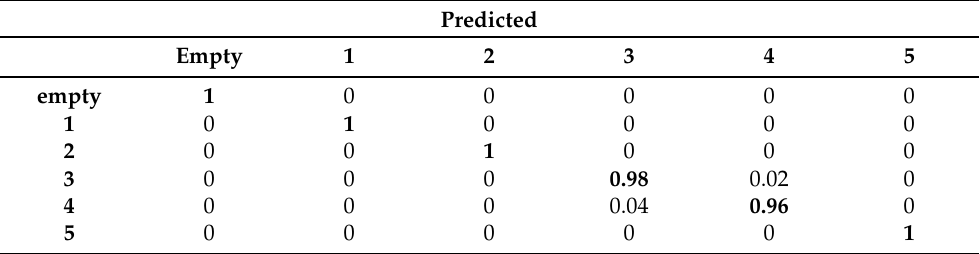
Table 2. Confusion matrix in room A with maximum 5 people and Decision Tree Classifier.